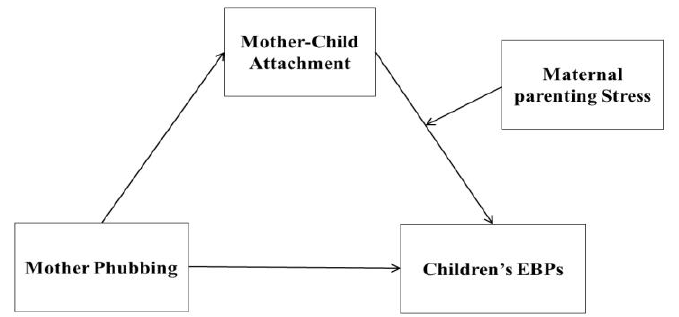
Figure 1. Research hypothesis